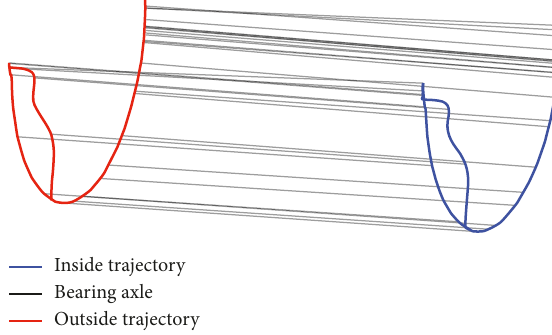
Figure 16: Trajectories and bearing axles of 3D joints in simulation.